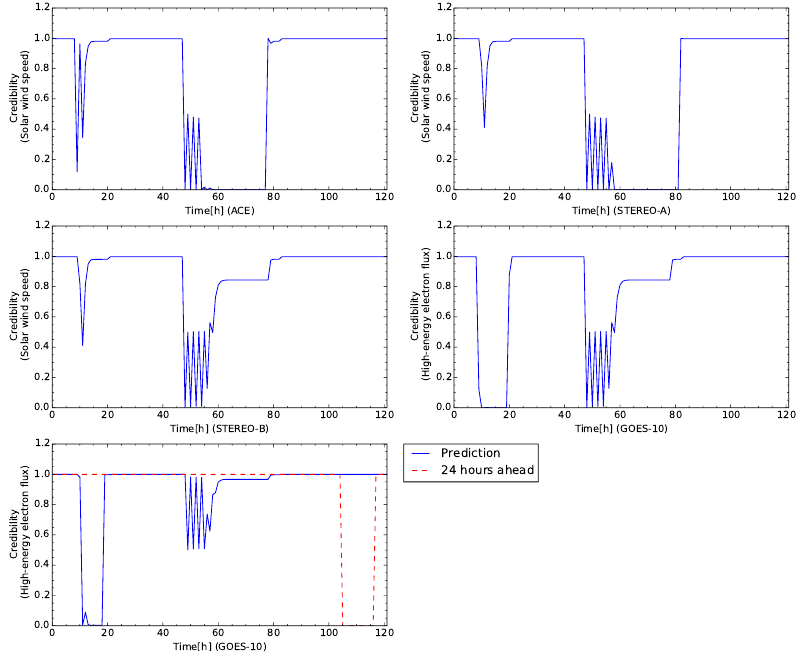
Figure 12. Time development of the credibility of each sensor for the test case shown in Figure 9. The satellite names are labeled in horizontal axes. The plots in the first row and the left one in the second row show the time development of the credibility for the solar wind speed. The right plot in the second row (in the third row) show the time development of the high-energy electron flux (high-energy electron flux 24 h